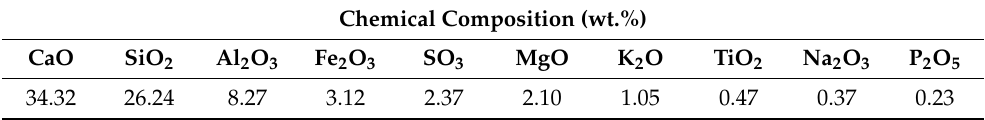
Table 2. Chemical composition of concrete slurry waste (obtained by XRF spectroscopy).